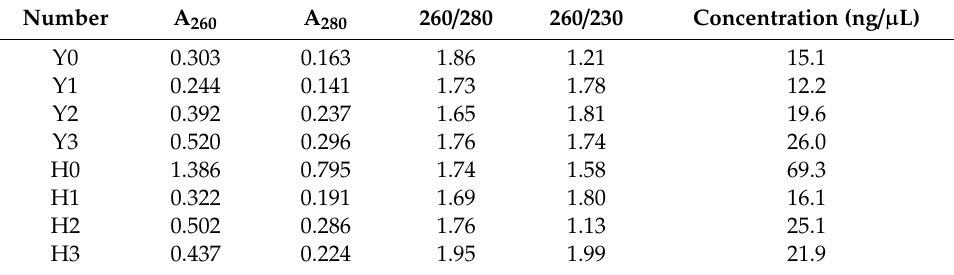
Table 2. DNA test results of selected samples.